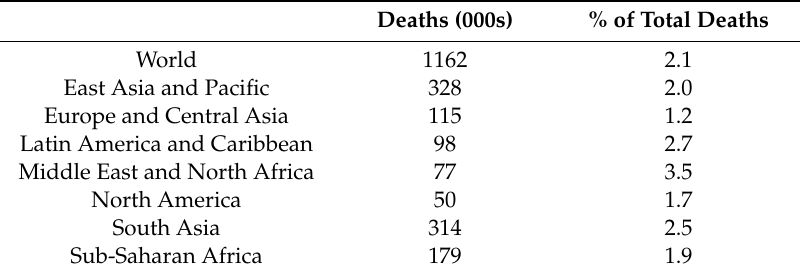
Table 1. The whole number of deaths and the corresponding percentage of the total number of deaths for each Country are reported. The WHO reports, in the Global Health Estimates (Geneva, 2016), the number of liver-related deaths by cause, age, sex, Country and Region during the years 2000–2015 [3].